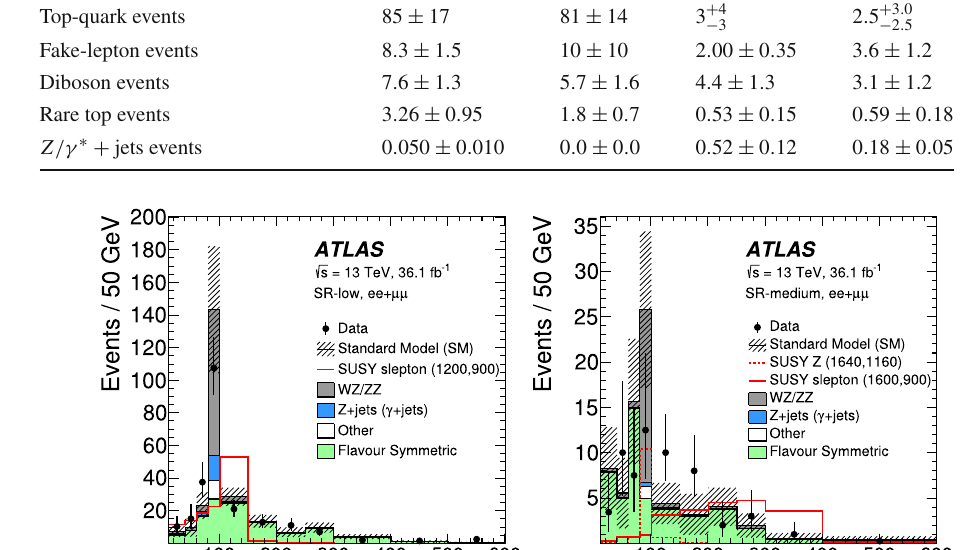
Fig. 9 Observed and expected dilepton mass distributions, with the bin boundaries considered for the interpretation, in (top left) SR-low, (top-right) SR-medium, and (bottom) SR-high of the edge search. All statistical and systematic uncertainties of the expected background are included in the hatched band. The last bin contains the overflow. One (two) example signal model(s) are overlaid on the top left (top right, bottom). For the slepton model, the numbers in parentheses in the legend indicate the gluino and ˜ χ 0 1 masses of the example model point. In the case of the Z model illustrated, the numbers in parentheses indicate the gluino and ˜ χ 0 masses, with the ˜ χ 0 2 1 mass being fixed at 1 GeV in this model